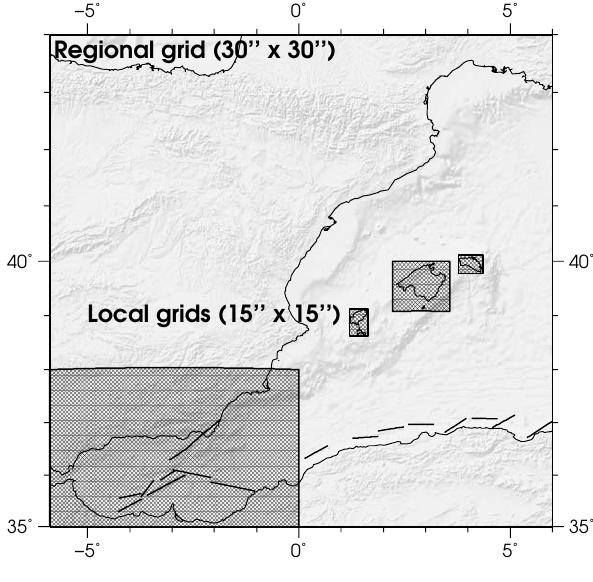
Fig. 2. Used grids. The regional grid has a cell size of 30 00 and the local nested grids (shaded rectangles) have cell sizes of 15 00